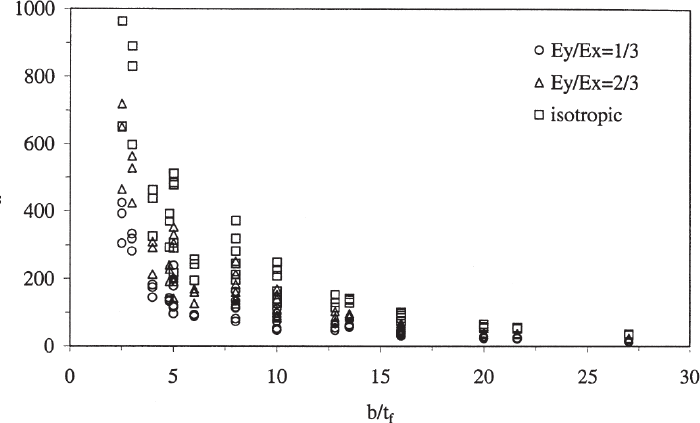
Figure 8. Critical buckling stresses versus the wall slenderness of I-shape PFRP profiles for different levels of orthotropy [81] (Ex and Ey are the longitudinal and transverse modulus, respectively).